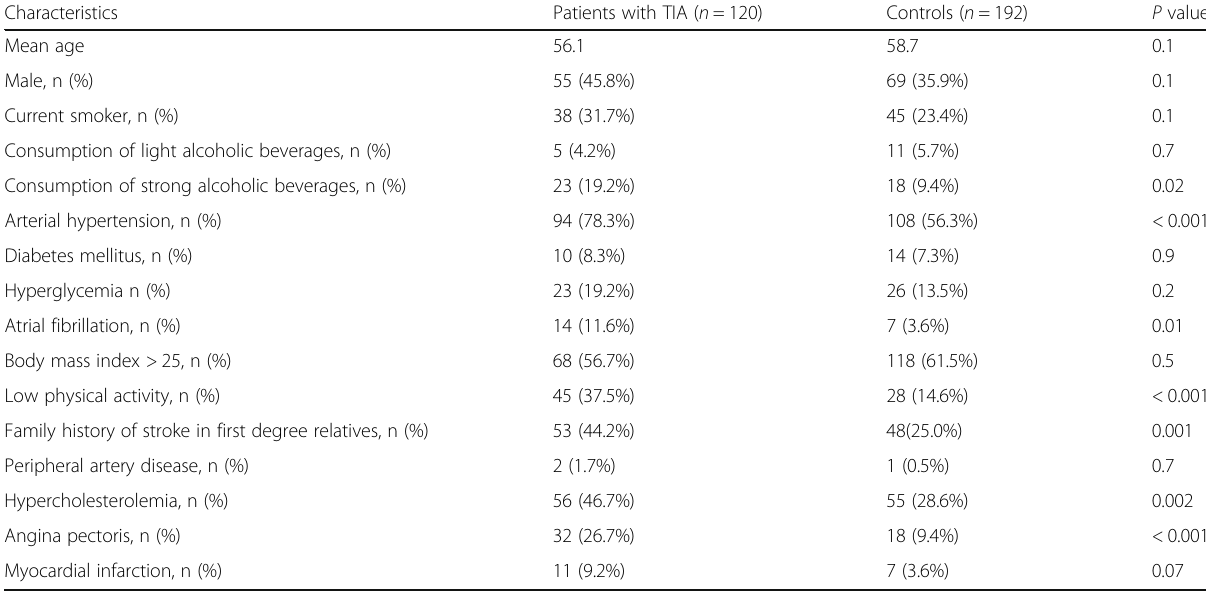
Table 2 Clinical characteristics of patients with TIA and controls